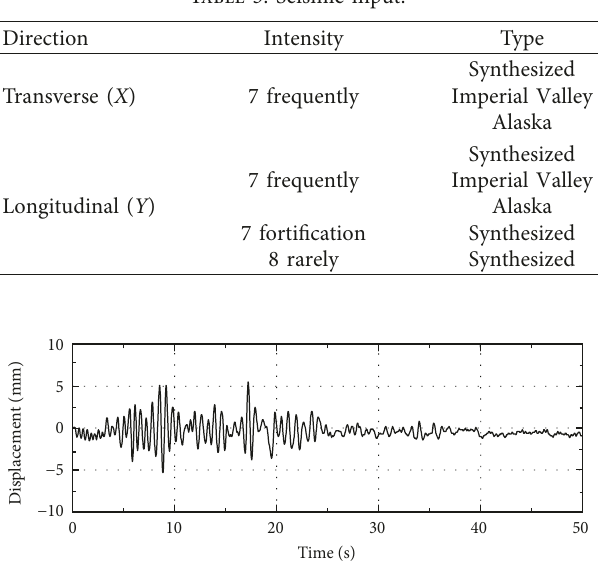
Figure 12: Displacement response curve of intensity 7 frequently of synthesized (transverse input).